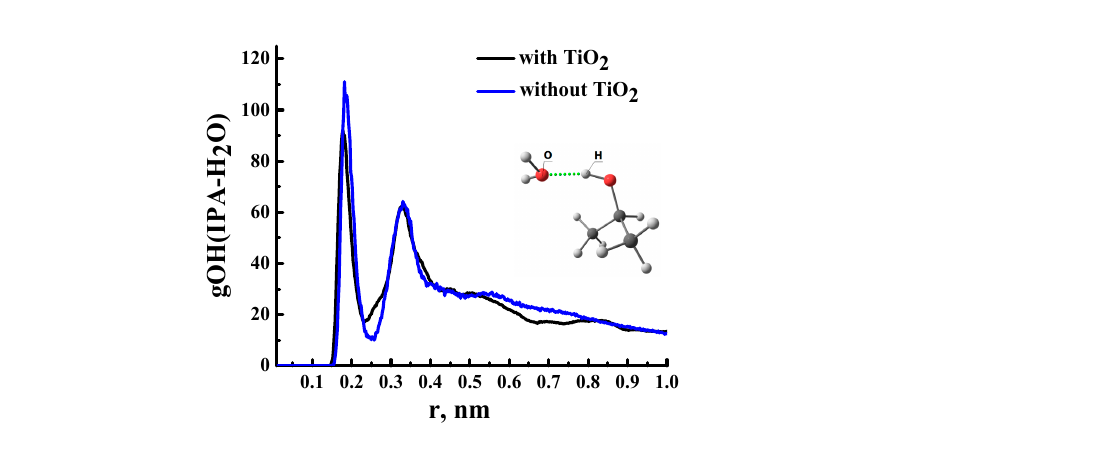
Figure 12. Number of hydrogen bonds between ( a ) water molecules and ( b ) water and isopropanol molecules per 100 solvent molecules.